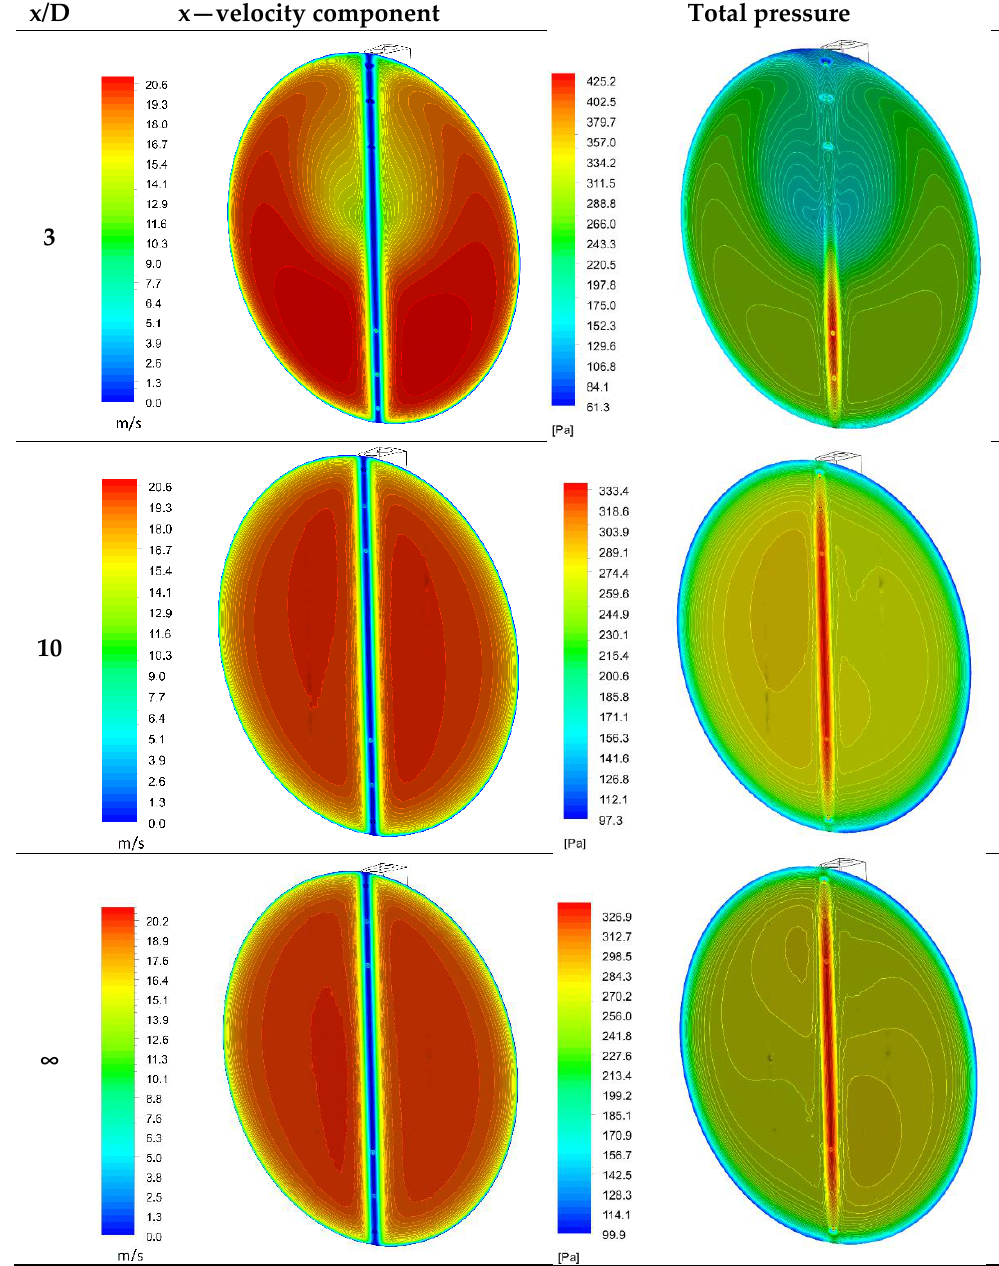
Figure 10. Distributions of axial velocity and total pressure in the tangential plane upstream of the streamlined probe (for mean velocity w = 18 m/s).